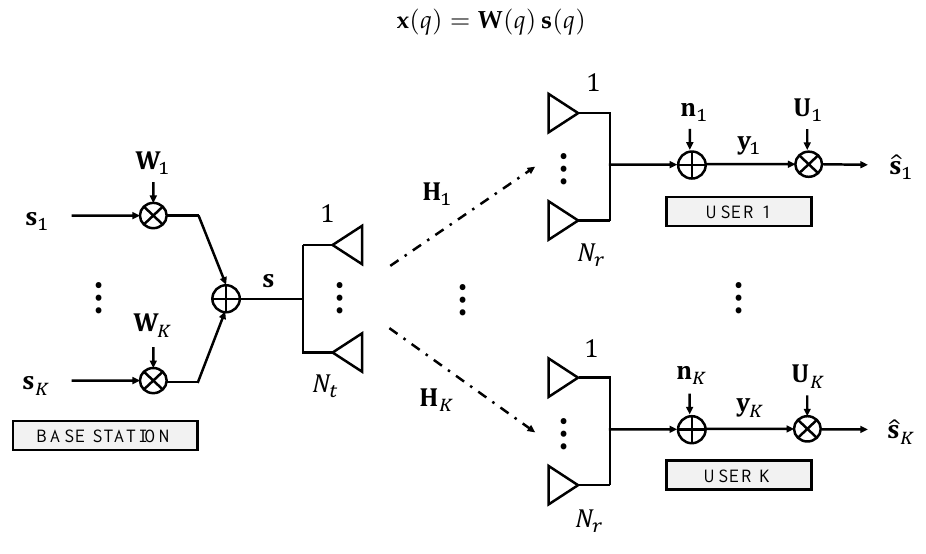
Figure 5. Multi-User Multi-Layer MIMO